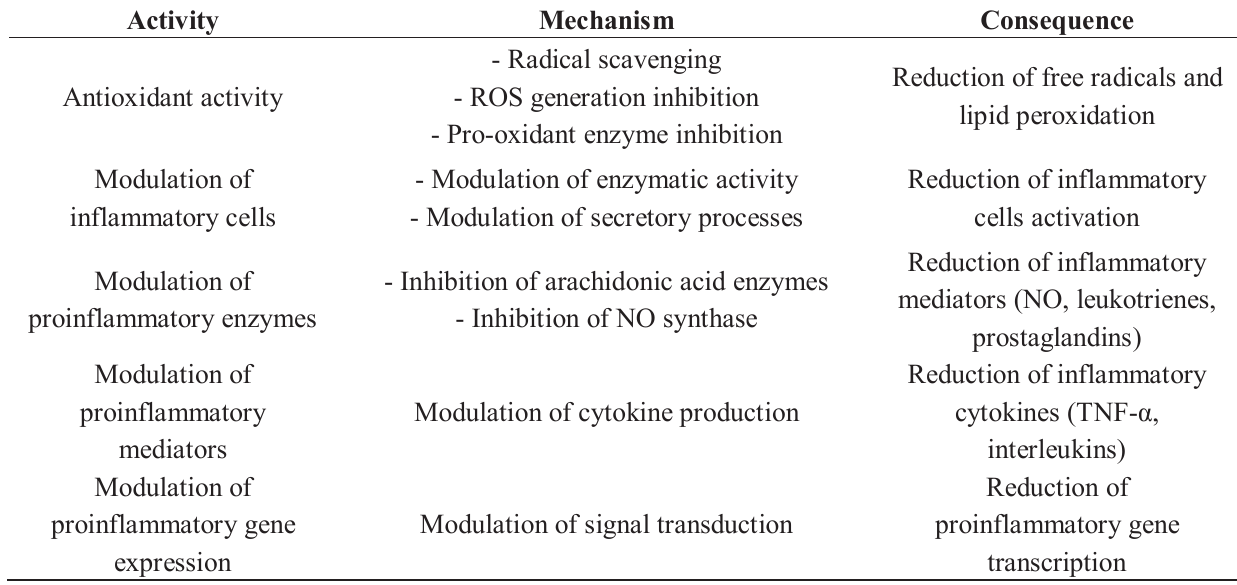
Table 4. Anti-inflammatory mechanisms of flavonoids (adapted from Garcia-Lafuente et al.